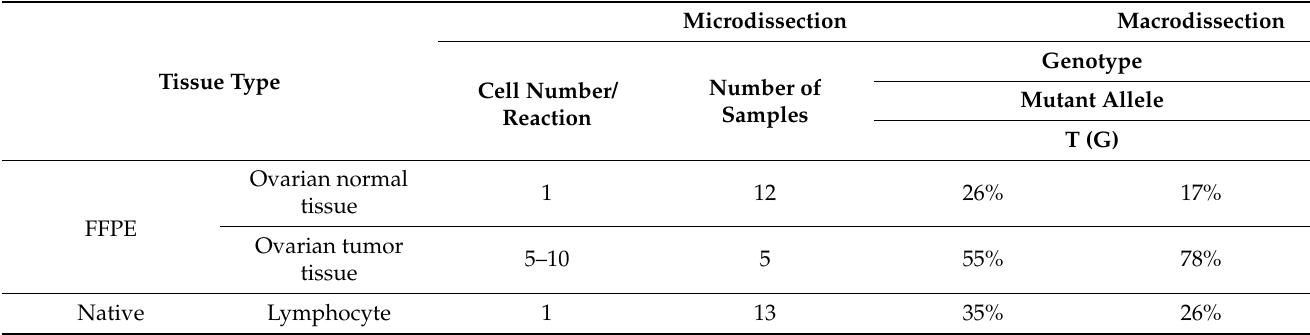
Figure 2. Schematic representation of the theoretical formation of BRCA2 mosaicism based on our results: ( A ) fertilized egg cell; ( B ) in the two-cell stage (or early in embryonic development), a G to T mutation in position 7795 of BRCA2 occurs, generating a heterozygous cell; ( C ) stemming from this single-mutated cell and wild-type cell(s), cell divisions result in a situation when every second cell will be heterozygous; ( D ) in the developed human body, cells will carry the mutated T allele with an approximate 25% frequency. Table 7. Final summary of the sequenced single cells/bulks of 5–10 cells, compared to the macrodissected samples from the same tissue with G/T ratios.